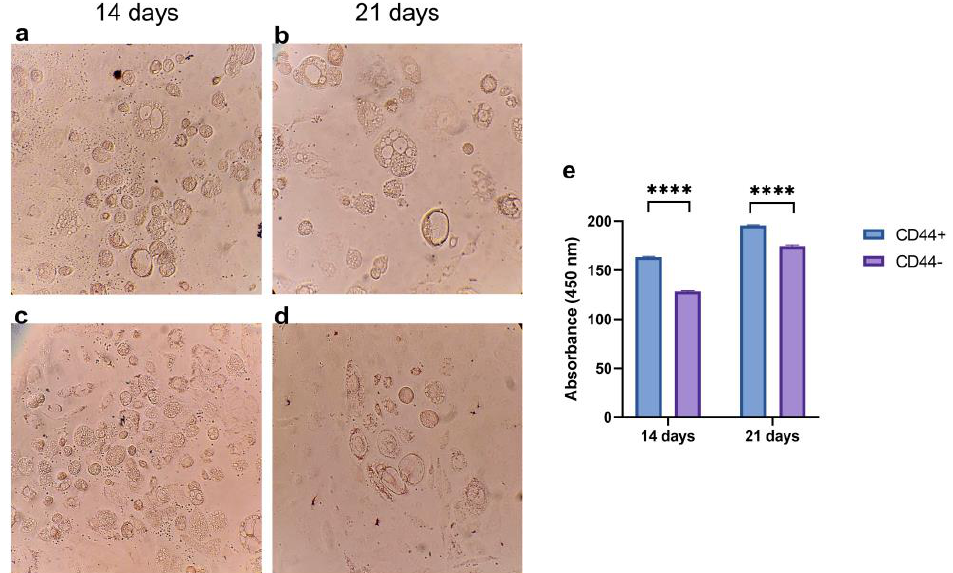
Figure 6. Adipogenic differentiation potential of CD44 + and CD44 − cells. Formation of neutral triglycerides and lipids by CD44 + cells after 14 ( a ) and 21 days ( b ); and CD44 − cells after 14 ( c ) and 21 days ( d ). Quantification of Oil Red O staining ( e ). All microphotographs are at 200 × magnification. CD44 + —CD44-positive cells, CD44 − —CD44-negative cells, and **** p ≤ 0.0001.